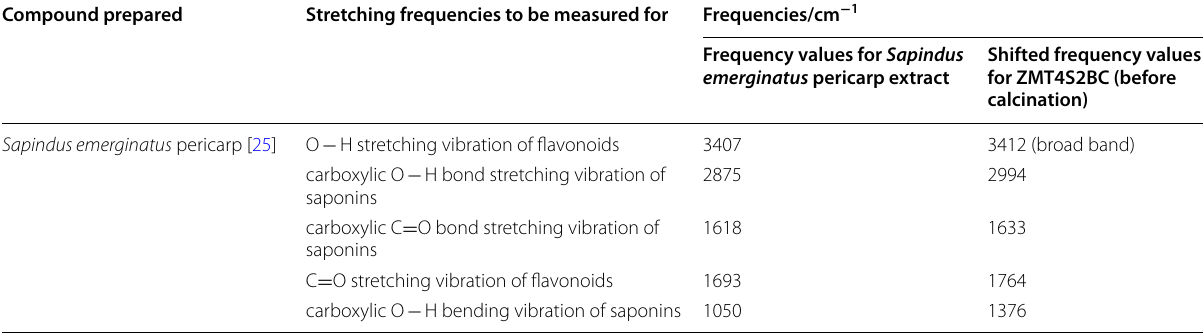
Table 2 Comparative stretching frequency values of pericarp extract and